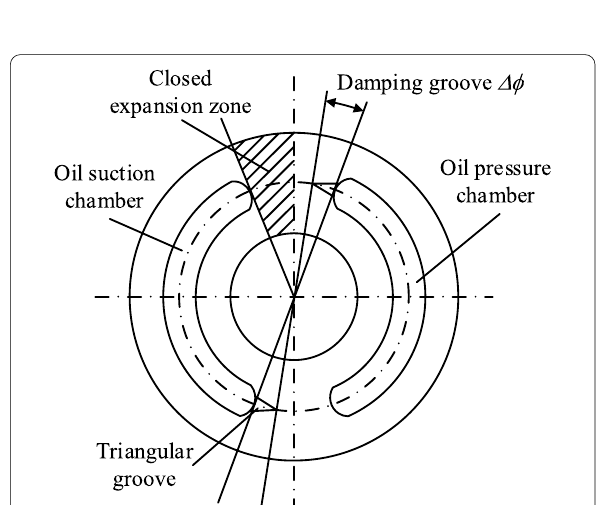
Figure 7 Plan view of distribution plate of piston